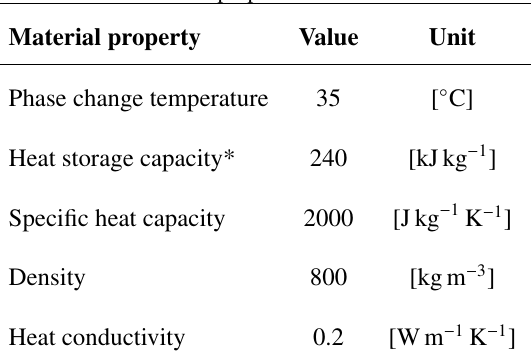
Table 1. Rubitherm RT 35 HC manufacturer properties